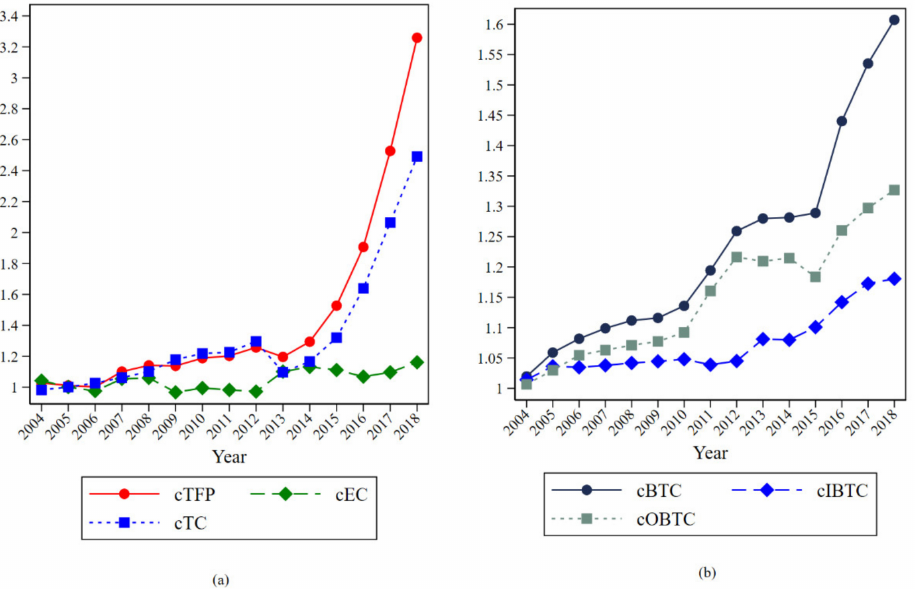
Figure 3. Trend of cumulative green total factor productivity and its decomposition term in China: ( a ) trend in the cumulative index of TFP, EC and TC. ( b ) trend in the cumulative index of BTC IBTC and